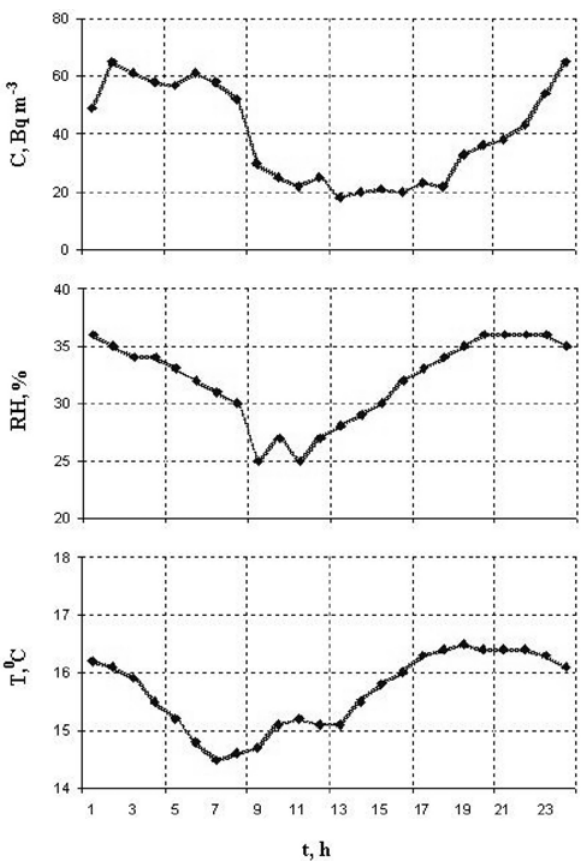
Fig 9. Dependency of 222 Rn progeny volumetric activity on temperature and relative humidity